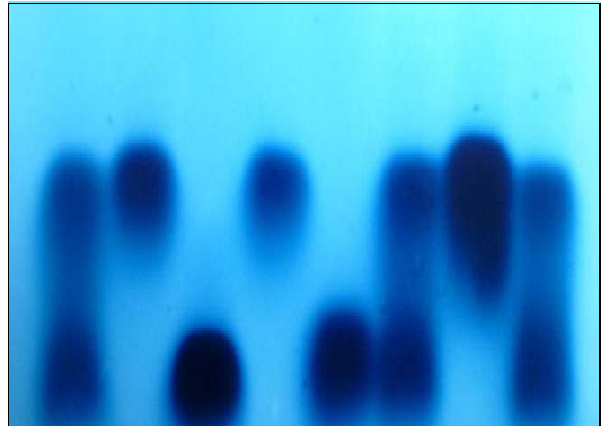
Figure-2: The observed haemoglobin polymorphism in Ogaden